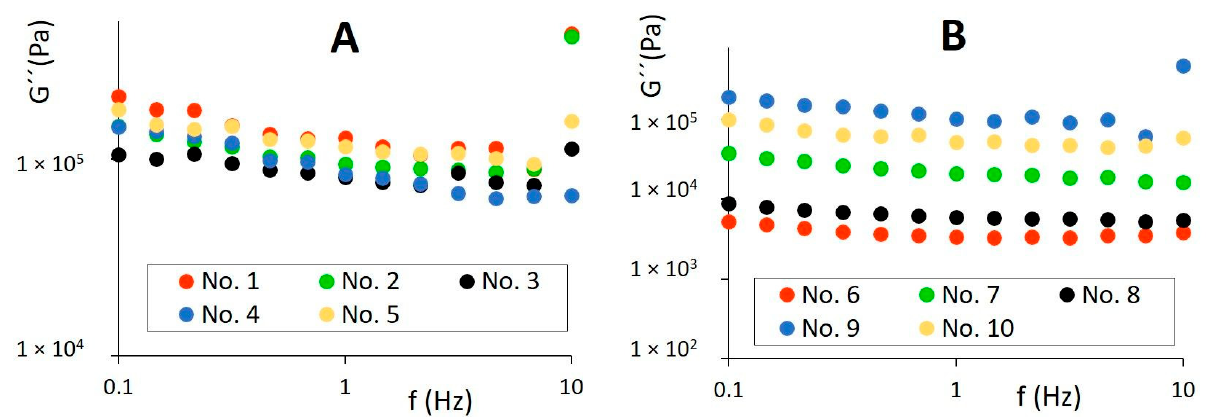
Figure 5. Viscous modulus (G ″ ) of butters ( A ), spreadable fats, and shortenings ( B ) dependent on frequency f in the region 0.1–10 Hz on logarithmic scale.